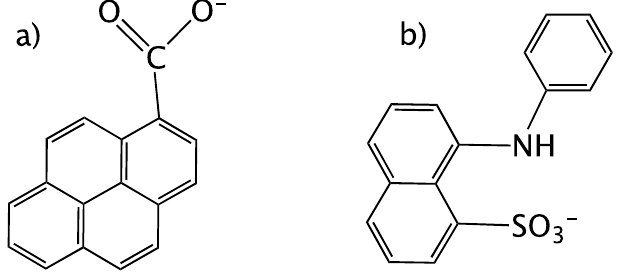
Figure 6. Luminescent anions: ( a ) 1-pyrenecarboxylate and ( b ) 8-Anilino-1-naphthalene sulfonate, respectively.